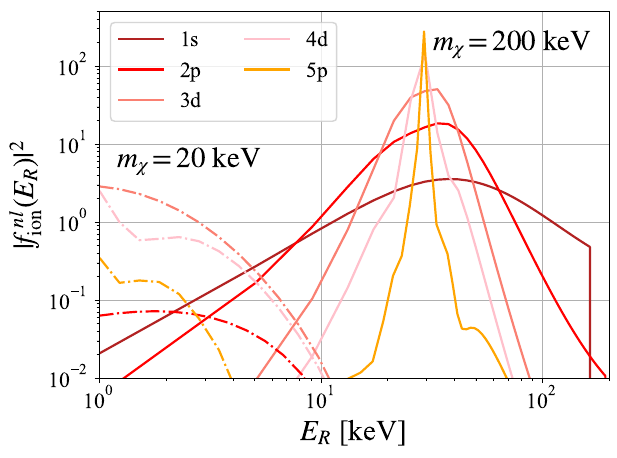
Figure 6 . The ionization form factors of some electron orbitals with m χ = 20 keV and 200 keV.